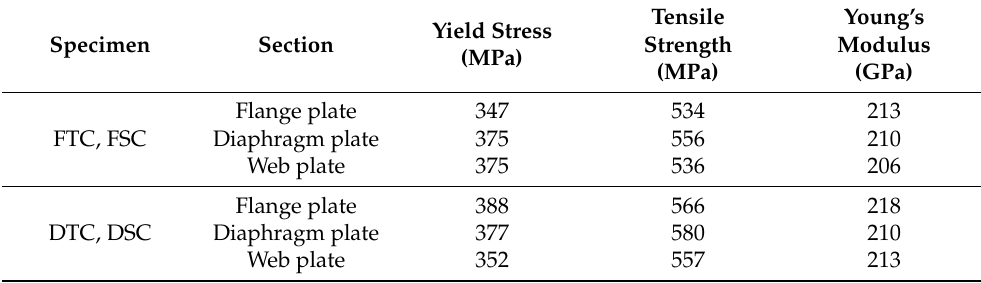
Table 3. Tensile coupon test results.